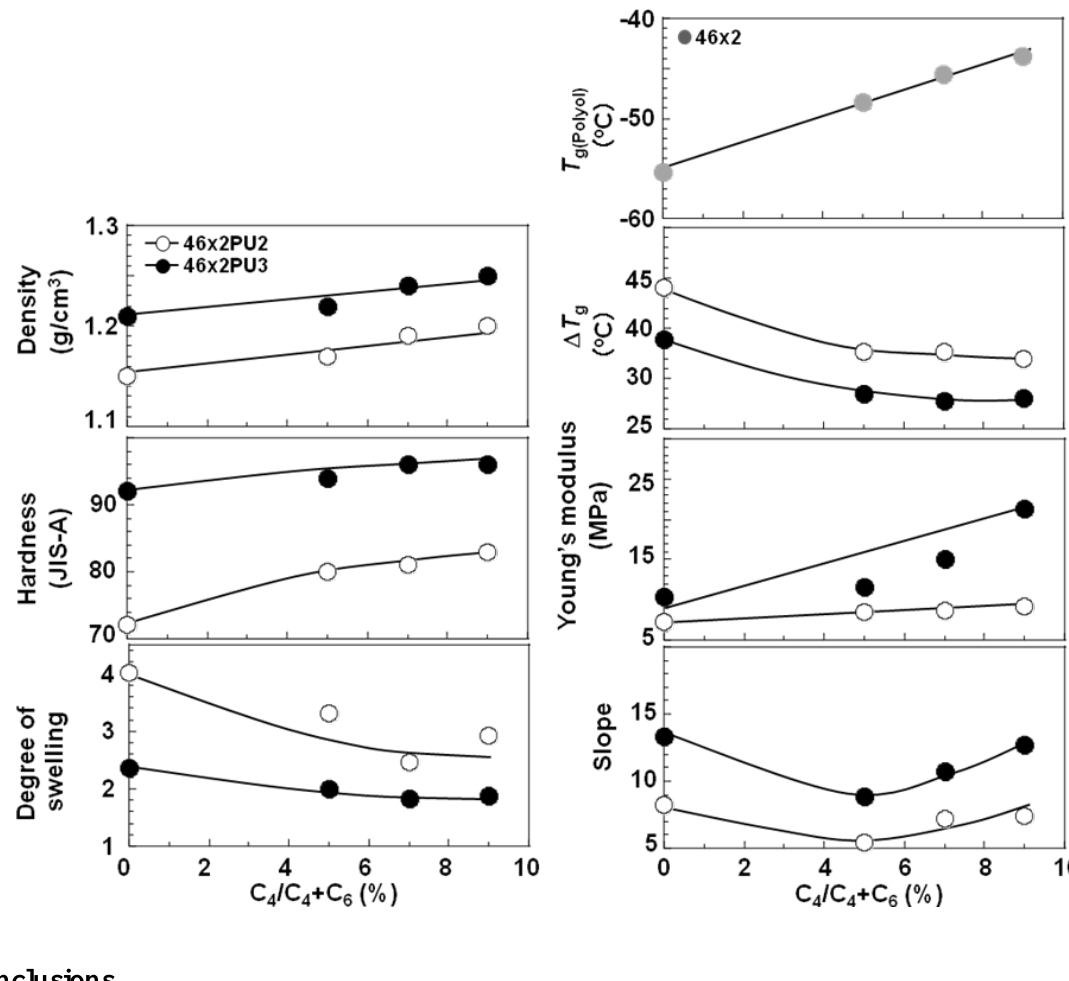
10. C composition ratio dependence of various properties for random 4 PC-glycol-based